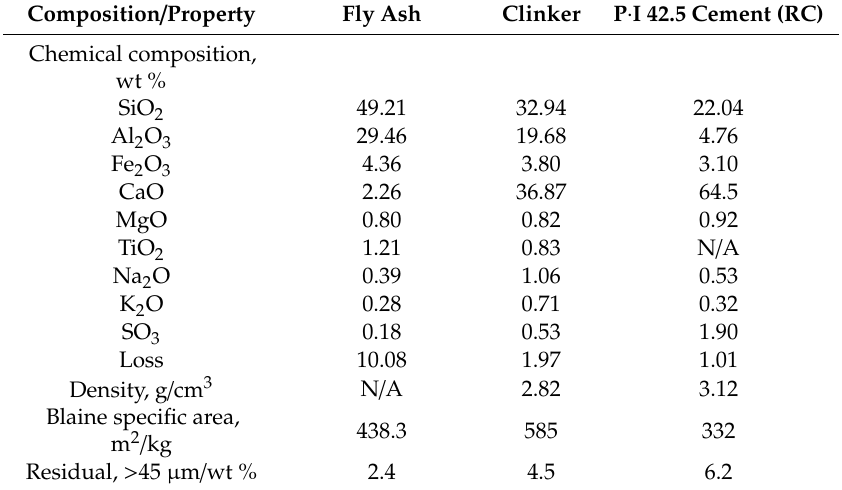
Table 1. Chemical composition and physical properties of fly ash, clinker, and reference cement (RC). Composition / Property